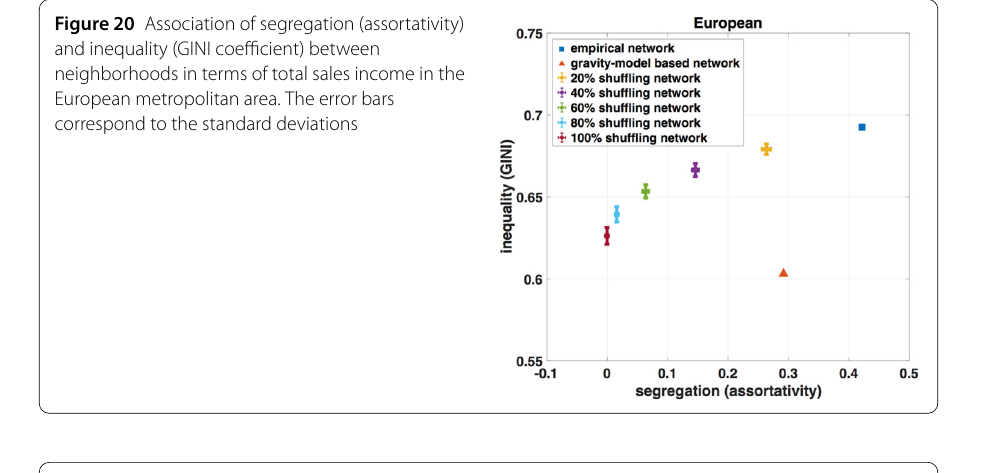
Figure 21 Association of segregation (assortativity) and inequality (GINI coefficient) between neighborhoods in terms of total sales income in the Latin American metropolitan area. The error bars correspond to the standard